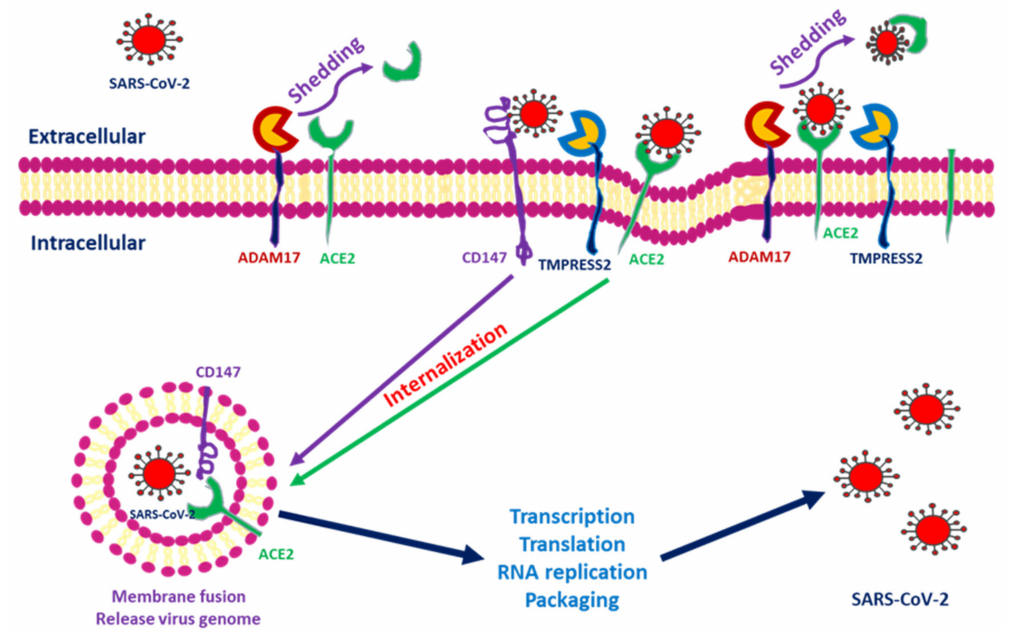
Figure 1. Severe acute respiratory syndrome coronavirus 2 (SARS-CoV-2) entry into cells through interactions among angiotensin-converting enzyme 2 (ACE2), transmembrane protease serine 2 (TMPRSS2), a disintegrin and metalloprotease 17 (ADAM17) and CD147. After SARS-CoV-2 interacts with the cells, ACE2 conjugates with the spike protein of SARS-CoV-2. TMPRSS2 interacts with the spike protein and facilitates internalization. ADAM17 serves to shed SARS-CoV-2 by transforming ACE2 into a soluble form. CD147 expressed within the transmembrane also facilitates entry and induces downstream inflammatory cytokine